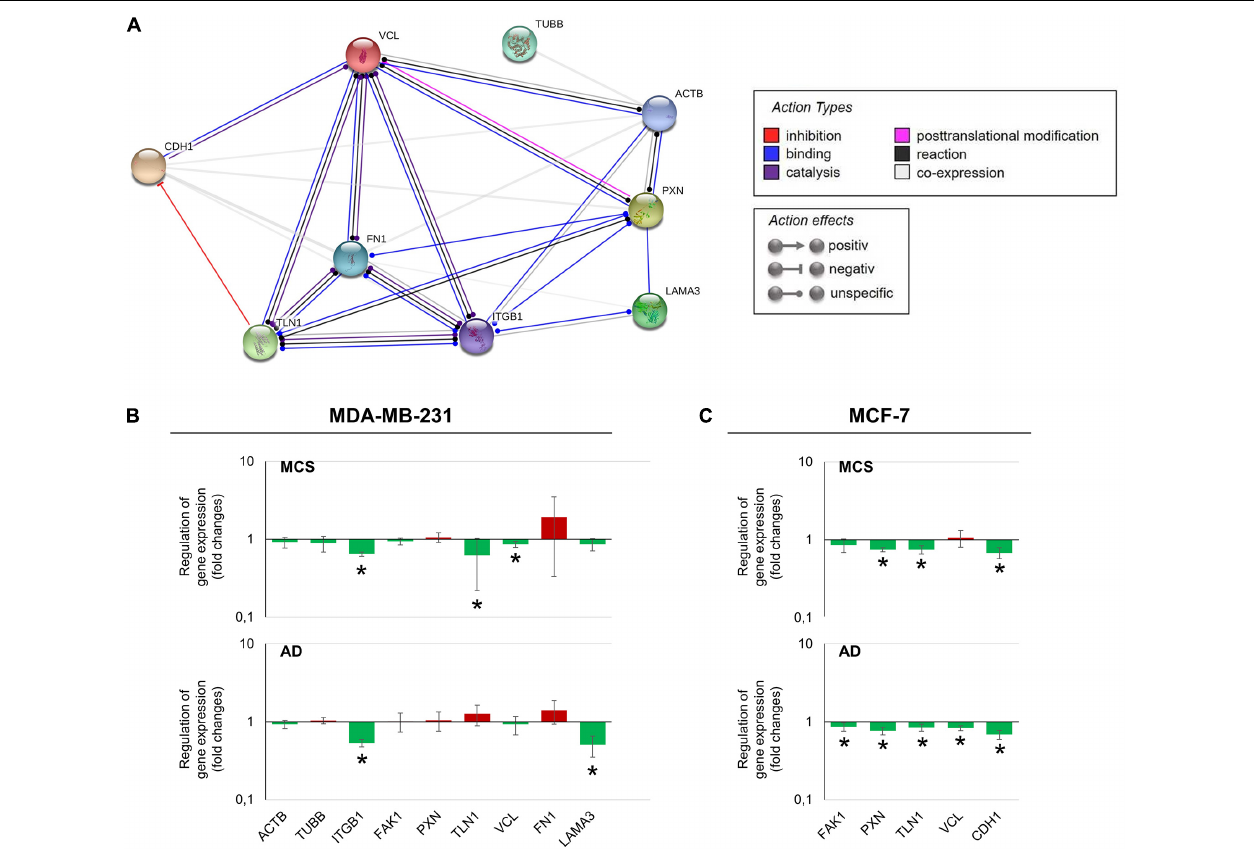
FIGURE 7 | (A) Network of the functional interaction of genes and their products analyzed in this study. The analysis was performed by STRING (Search Tool for the Retrieval of Interacting Genes/Proteins, v11.0) provided by the STRING Consortium (available online: https://string-db.org/). The result is presented in the molecule action mode. Gene names are indicated. (B) Summary of the gene expression fold change measured by qPCR of 24 h RPM-exposed MDA-MB-231 samples. Results determined in AD and MCS in relation to 1 g were given. The red color indicates up-regulated genes and the green color down-regulated genes. (C) Summary of the gene expression fold change measured by qPCR of 24-h RPM-exposed MCF-7 samples. The * indicates a significant change in fold